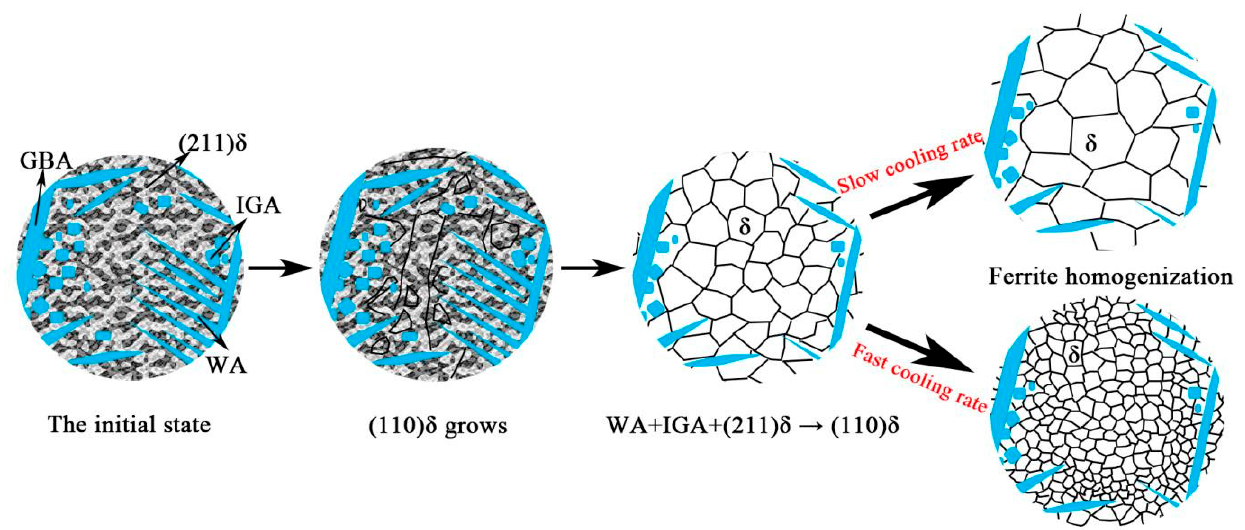
Figure 9. Diagram of the grain growth in as-remelted process.